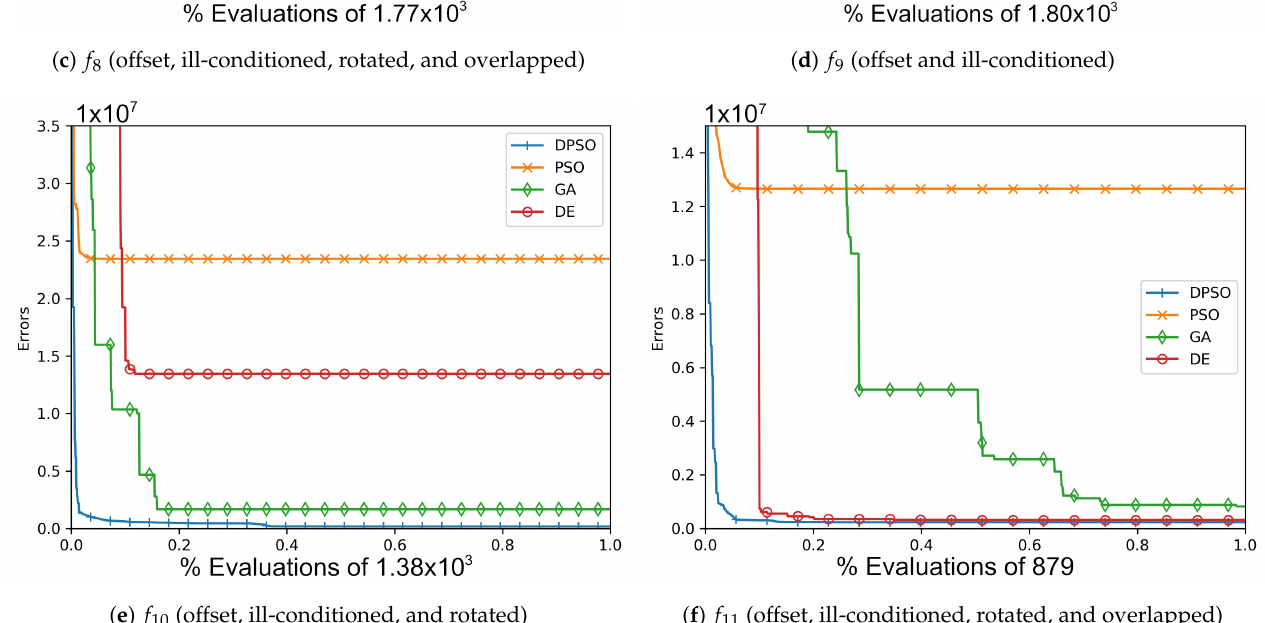
Figure A6. The average Ackley ( f 6 , f 7 , f 8 ) and Rosenbrock ( f 9 , f 10 , f 11 ) global best results over time for 21